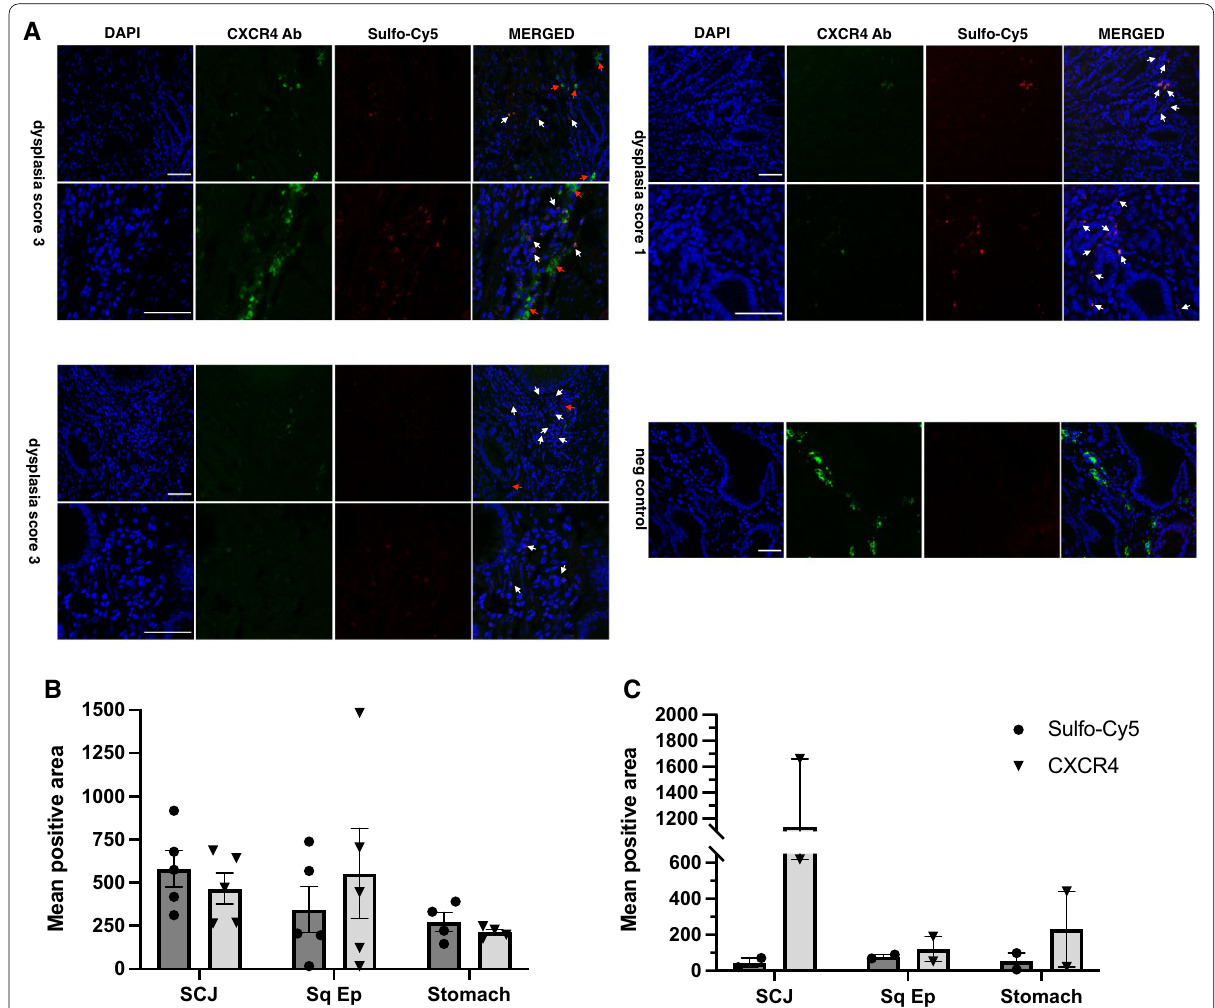
Fig. 3 Co‑localization of CXCR4 and Sulfo‑Cy5 signal in lesions at the squamocolumnar junction of IL1B mice. A Representative confocal images of stomach of injected IL1B mice of different grade of dysplasia and of one negative control (12 months old). Orange/yellow fluorescence indicated the co‑localization of MK007 signal with CXCR4 Ab (white arrows) next to dysplastic areas at the SCJ. In some CXCR4 cells, no MK007 uptake + was observed (red arrows). The staining for CXCR4 was performed with anti‑CXCR4 Ab conjugated with PE as described in the Methods section. Sulfo‑Cy5 signal was detected by using Cy5.5 red channel. Scale bars represent 50 μm. B Quantification of CXCR4 expression and Sulfo‑Cy5 signal in SCJ, squamous epithelium (Sq Ep) and glandular epithelium (Stomach): in the SCJ, the mean CXCR4 and Sulfo‑Cy5 signal were 580.6 105.2 and ± 465.8 89.19, respectively. A much lower CXCR4 expression (211.9 15.74) and Sulfo‑Cy5 signal (272.8 54.99) were detected in the glandular ± ± ± epithelium. One mouse presented a high CXCR4 expression in the inflamed squamous epithelium but without an increase of Sulfo‑Cy5 signal. Data are represented as single plotted values and mean SEM ( n 5). C No Sulfo‑Cy5 signal (mean positive area < 100 pixels) was detected in negative ± = controls ( n 2). Signal quantification was expressed by calculating the mean positive area in pixels per each mouse and data are represented as = single plotted values and